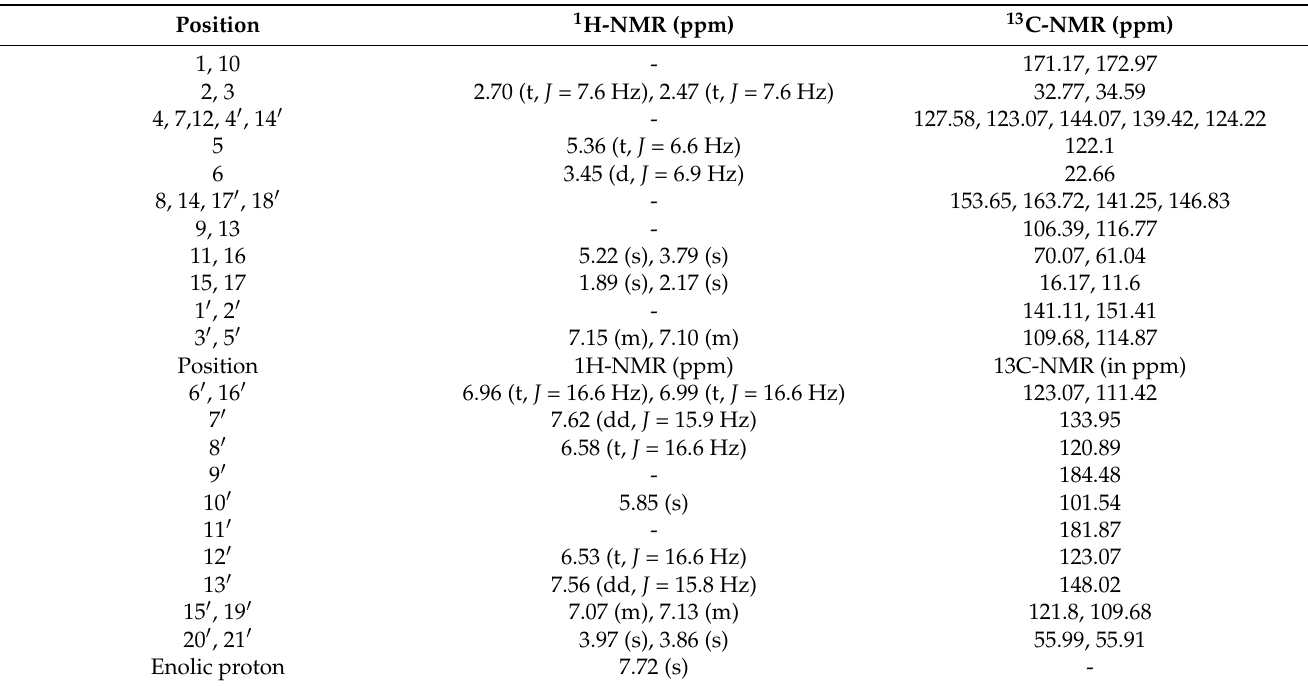
Table 1. 1 H and 13 C NMR spectral data of MPA-CUR conjugate in chloroform- d .